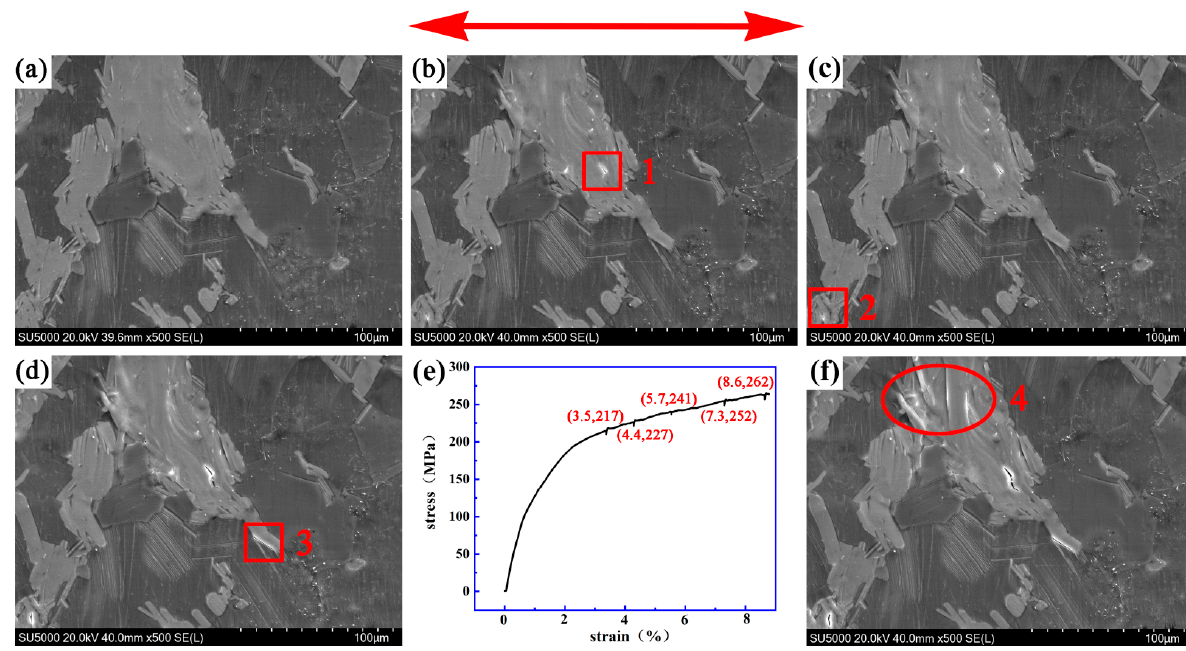
Figure 5. The dynamic process of crack initiating and extending in 510 ◦ C × 13 h solid solution Mg-13Gd-5Y-3Zn-0.3Zr alloy. ( a ) ε = 0, σ = 0 MPa. ( b ) ε = 3.5%, σ = 217 MPa. ( c ) ε = 4.4%, σ = 227 MPa. ( d ) ε = 5.7%, σ = 241 MPa. ( e ) The stress–strain curve. ( f ) ε = 7.3%, σ = 252 MPa.